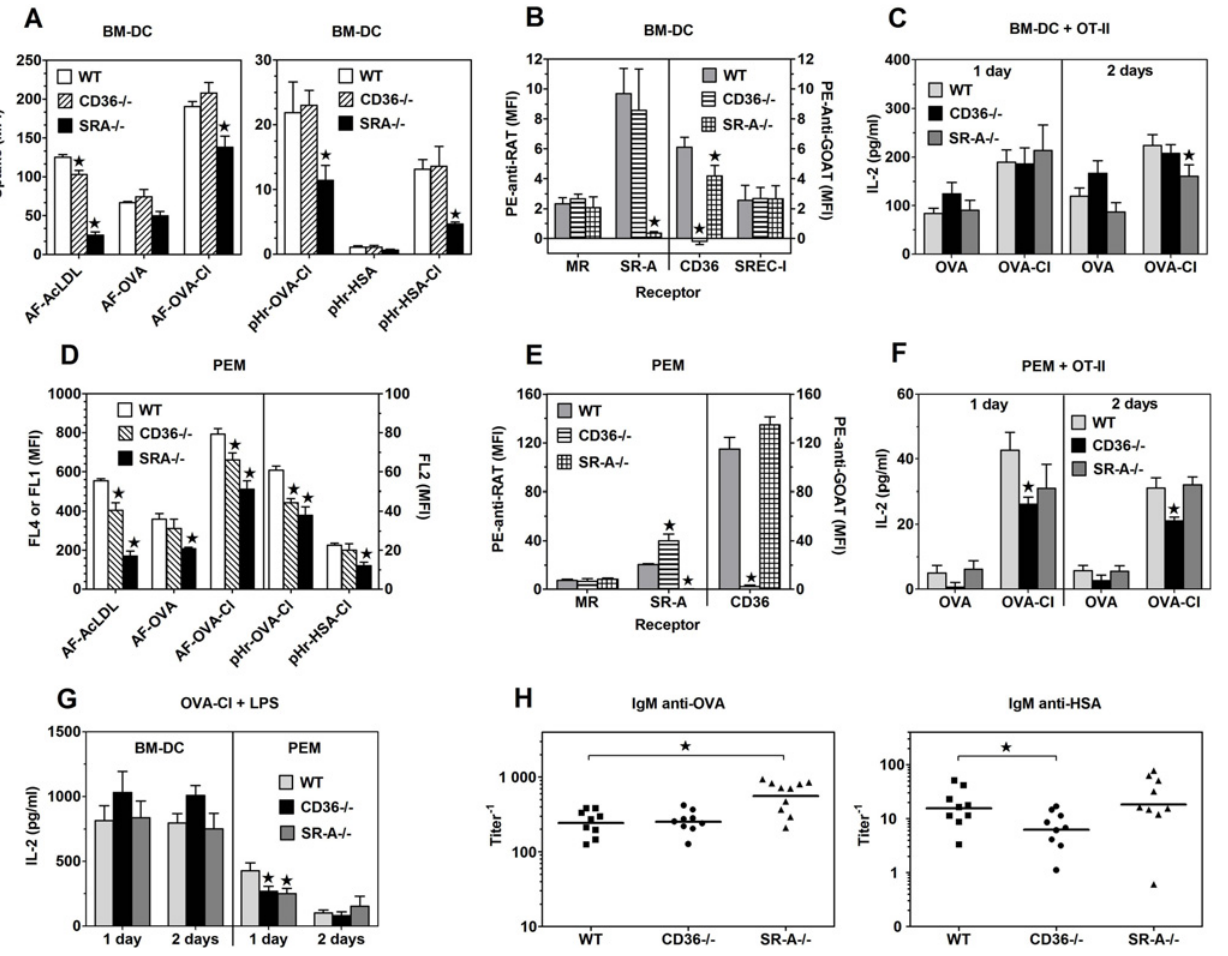
Fig 3. Effects of SR-A or CD36 deficiency on antigen uptake, expression of endocytic receptors and antigen presentation to CD4 + OT-II splenocytes. ( A , D ) Uptake of indicated, fluorescently labelled proteins, present at 5 μ g/ml by BM-DC (A) and PEM (D) was assessed by flow cytometry. ( B , E ) Specific binding of Ab to receptors (geometric mean fluorescence intensity) on BM-DC (B) and PEM (E) which was obtained by subtracting binding of control Ab from the total binding of receptor-specific Ab. ( C , F ) IL-2 production in 1- or 2-days co-cultures of BM-DC (C) or PEM (F) with CD4 + OT-II lymphocytes. Directly before the co-incubation with lymphocytes, APC were pulsed for 3.5 h with 20 μ g/ml OVA or 7 μ g/ml OVA-Cl. The data shown on graphs A-G are means +SEM from 6 – 8 independent experiments. ( H ) Titers of OVA- or HSA-specific IgM in sera of mice immunized 8 days earlier with 20 μ g OVA-Cl or HSA-Cl. Points represent titer values in individual mice and horizontal lines geometric means. The data were analysed with the regular (H) or repeated measures (A-G) ANOVA and the Dunnett ’ s post-test was used to make comparisons with the control groups (WT). * , p < 0.05.